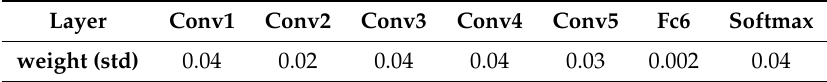
Table 3. Classification pathway parameter initialization (Gaussian distribution).